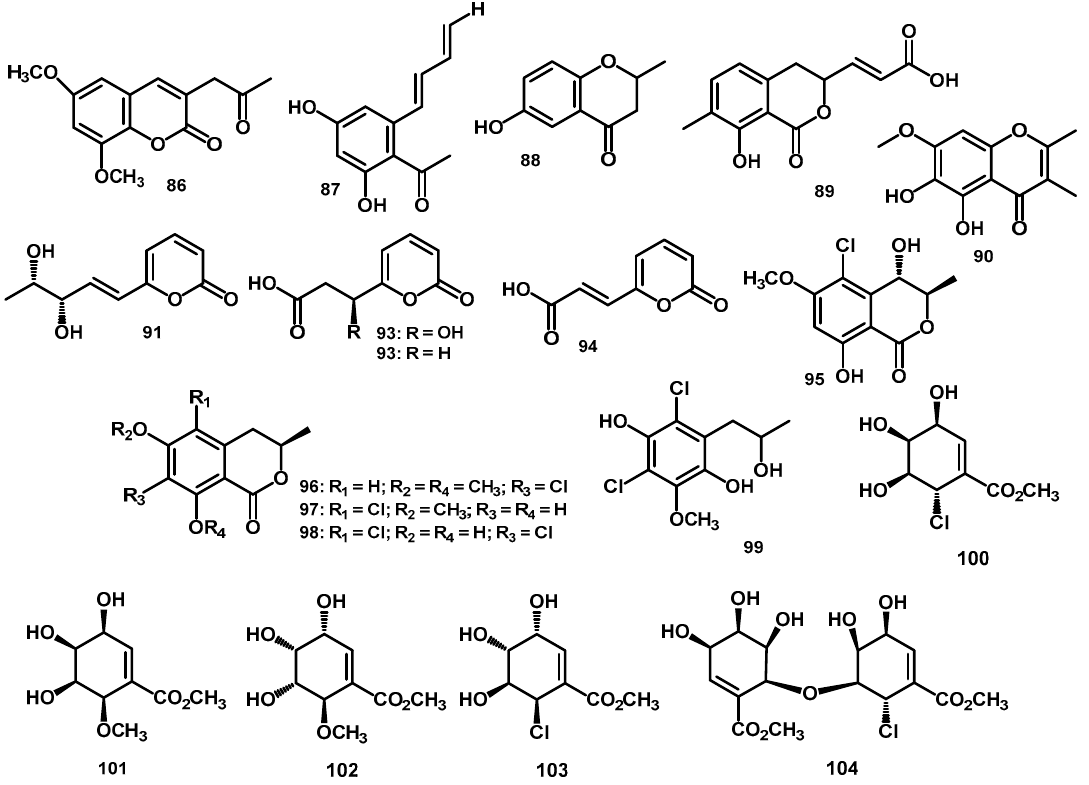
Figure 6. The chemical structures of aromatic compounds 86 – 99 and carbohydrate derivates 100 – 104 from the Periconia genus.